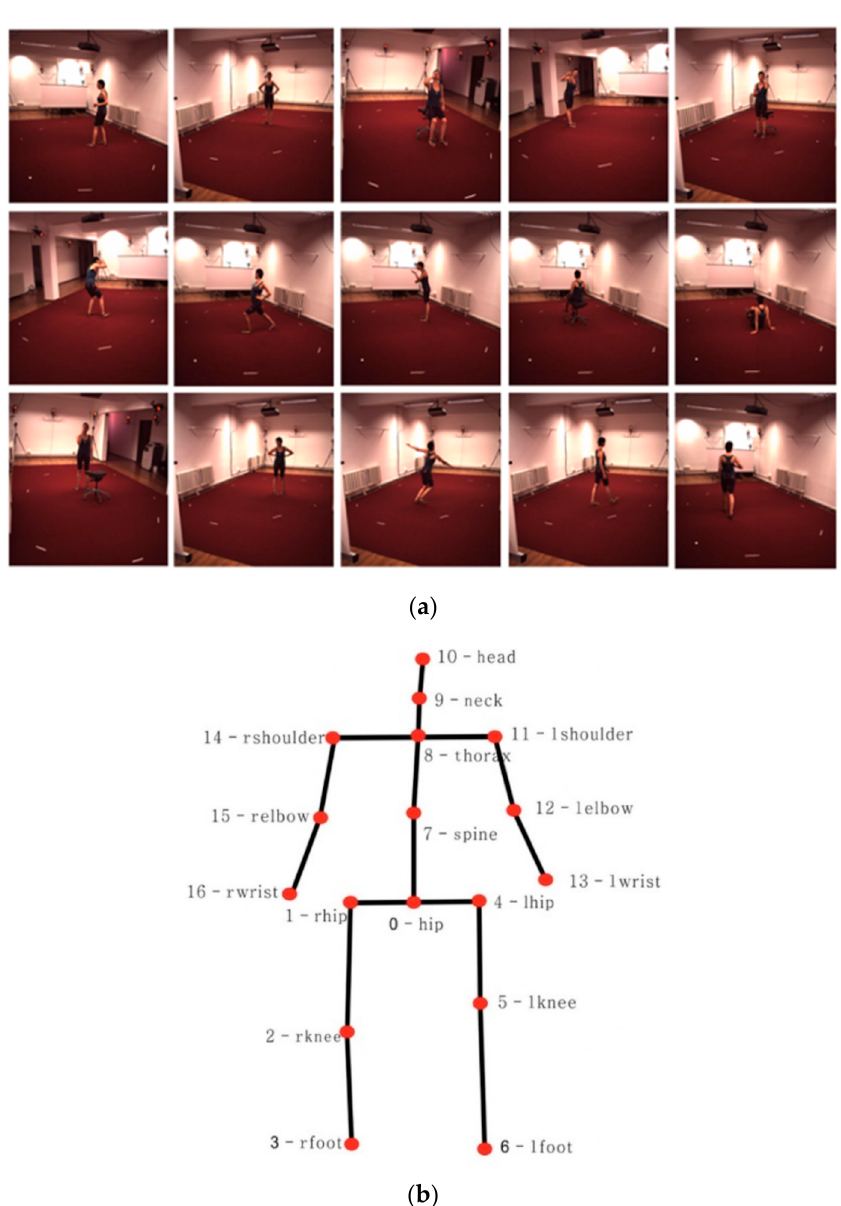
Figure 7. ( a ) Images from the Human 3.6M dataset; ( b ) skeleton topology in the Human3.6M da-